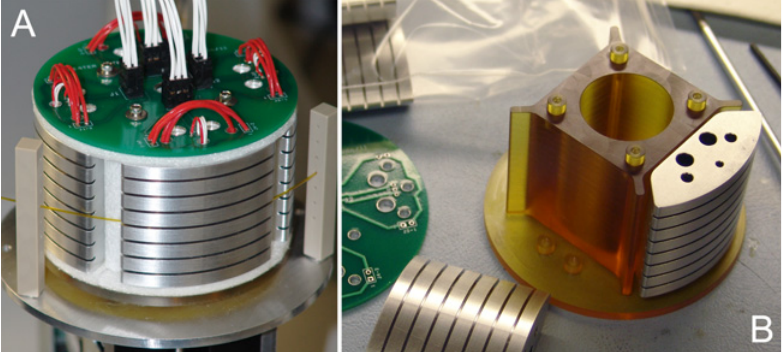
Fig 2. Rotary zone thermal cycler prototype. (A) Aluminum heater blocks with seven capillary grooves for parallel operation feature embedded cartridge heaters and RTDs interfaced to a printed circuit board and wire harness. Guide posts to either side of the heated zone have through-holes to maintain capillary alignment in the groove and provide options for tensioning the tube against the wheel. (B) Disassembled RZTC wheel showing insulating hub structure and heater block geometry. Axial holes in the heater block are for mounting screws (large inner pair), cartridge heaters (smaller outer pair), and RTD (smallest central hole).